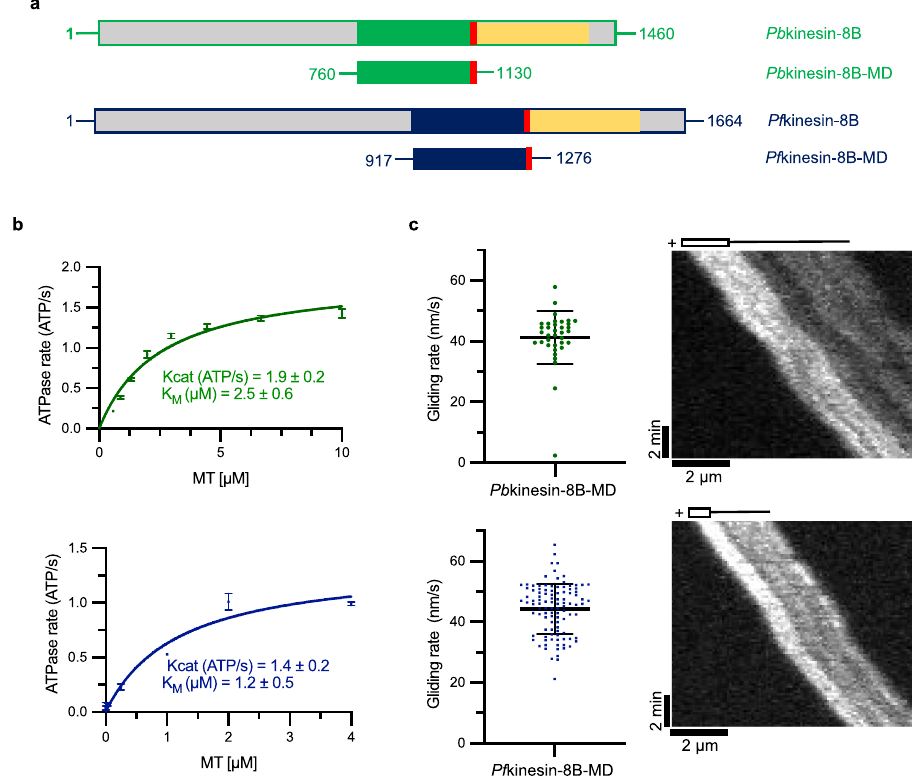
Fig. 1 | Plasmodium kinesin-8B motordomains areMT-dependent ATPasesand drive plus-end directed MT gliding. a Schematic representation of full-length Pb kinesin-8B (PBANKA_020270, top) and Pf kinesin-8B (PF3D7_0111000, bottom) domainorganisation,indicating therelationship withtheMDconstruct(themotor domain plus NL sequence); motor domains are coloured green ( Pb kinesin-8B) and blue ( Pf kinesin-8B), neck linkers are red and coiled-coil regions are yellow. b Both Pb kinesin-8B-MD (top — green) and Pf kinesin-8B-MD (bottom — blue) exhibit MT- stimulated ATPase activity ( Pb :GMPCPP-MT, Pf :paclitaxel-stabilised MT). ATPase assaydata( n =3foreachpoint, mean±SD)were fi tted using theMichaelis-Menten